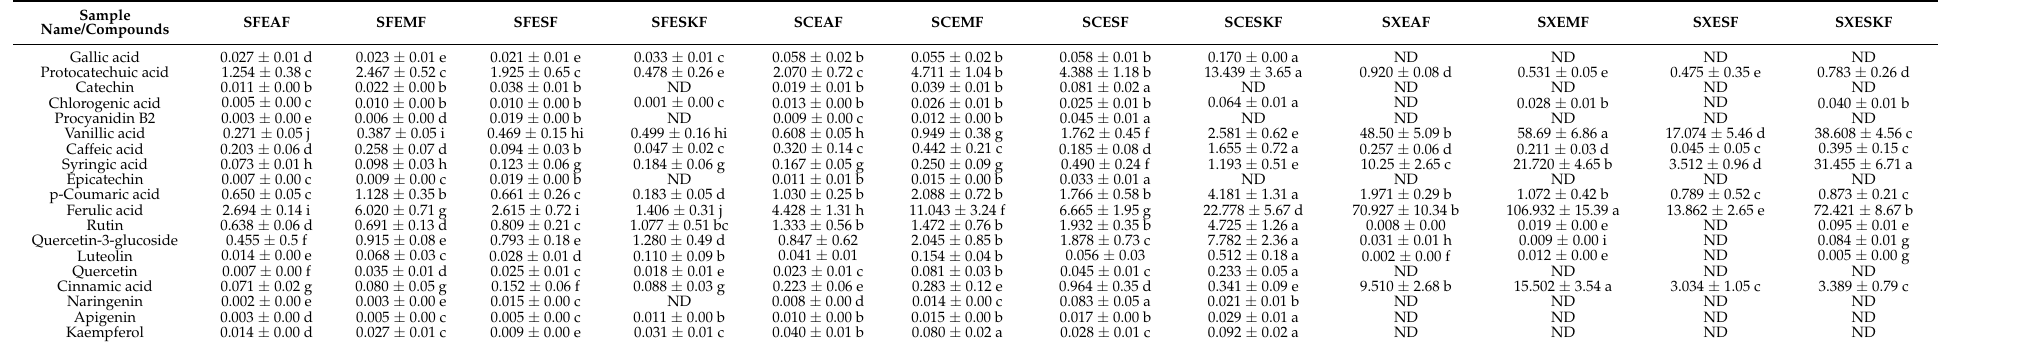
Table 1. Phenolic acids and flavonoids (mg/100 g extract) as detected by LC/MS in flesh extracts of four date fruit varieties (Ambara flesh (AF), Majdool flesh (MF), Sagai flesh (SF) and Sukari flesh (SKF)) using supercritical fluid (SFE), subcritical CO 2 (SCE) and Soxhlet (SXE) extraction